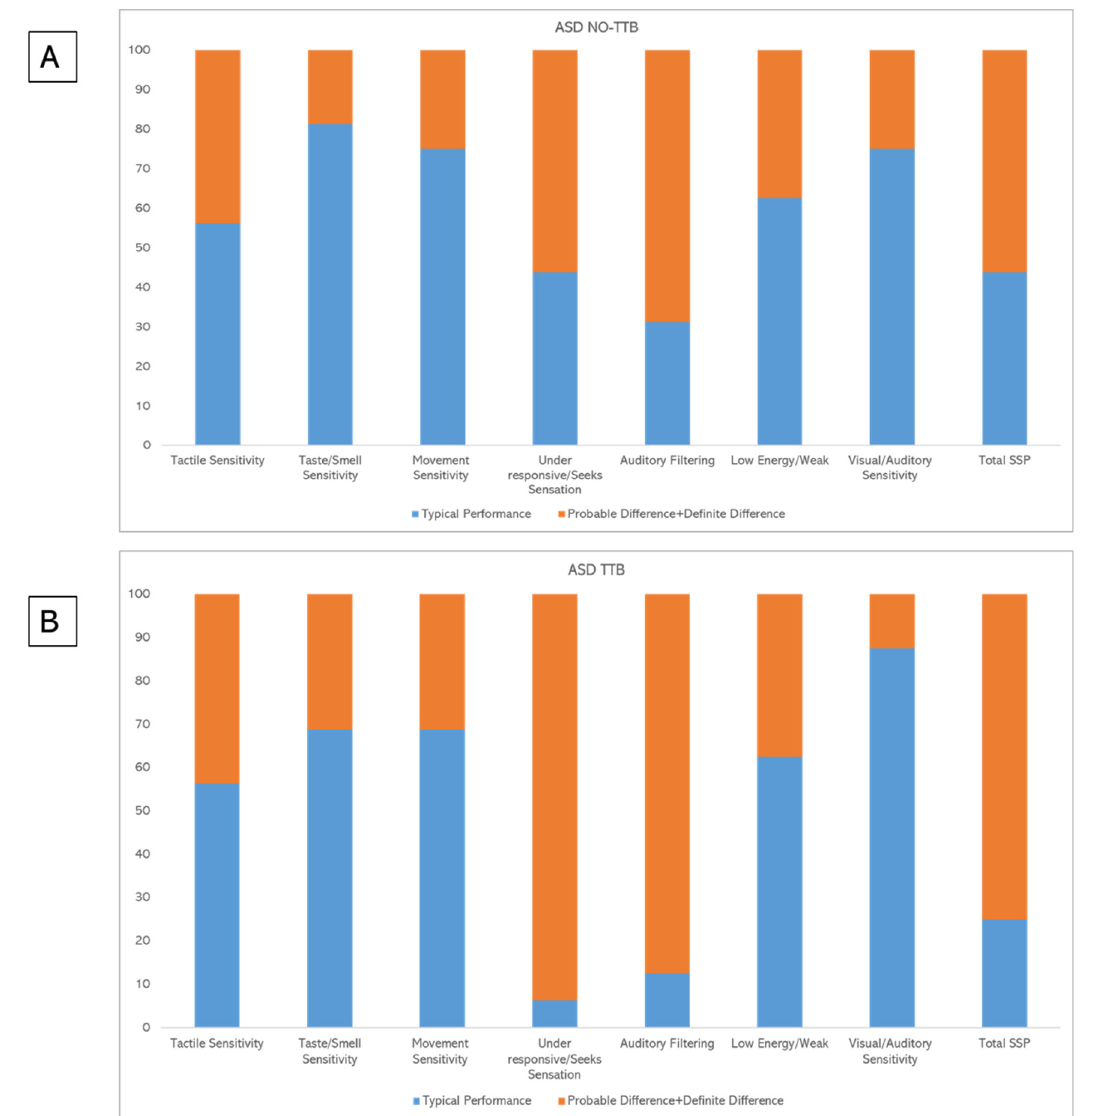
Figure 1. ( A ) Percentages of children that have scores in the normal or impaired ranges among the SSP1 scales in the ASD NO-TTB group. ( B ) Percentages of children that have scores in the normal or impaired ranges among the SSP1 scales in the ASD TTB group.